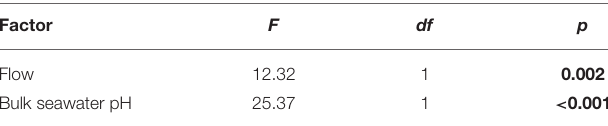
TABLE 3 | ANOVA summary for effects of flow and species on tissue surface pH of Favites and P. damicornis . Factor F df p Flow 52.48 1 < 0.001 Species 231.64 1 < 0.001 Bold values represent significant effects.